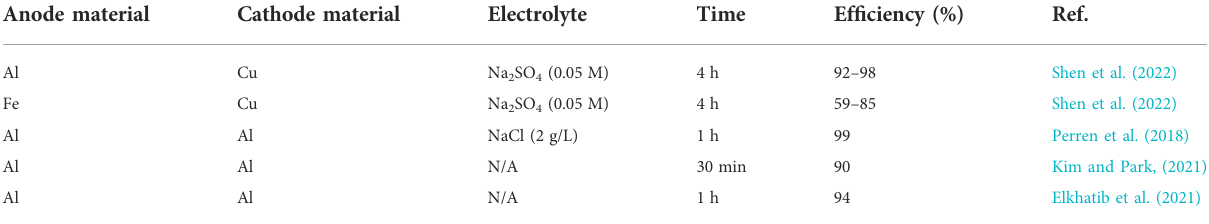
TABLE 1 The comparison of electrode material, electrolyte, reaction time and ef fi ciency of various electrocoagulation setups. Anode material Cathode material Electrolyte Time Ef fi ciency (%)